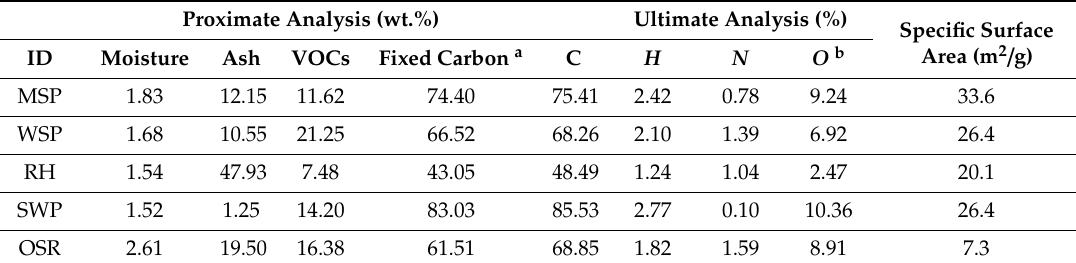
Table 2. Main chemical and physical properties of biochar